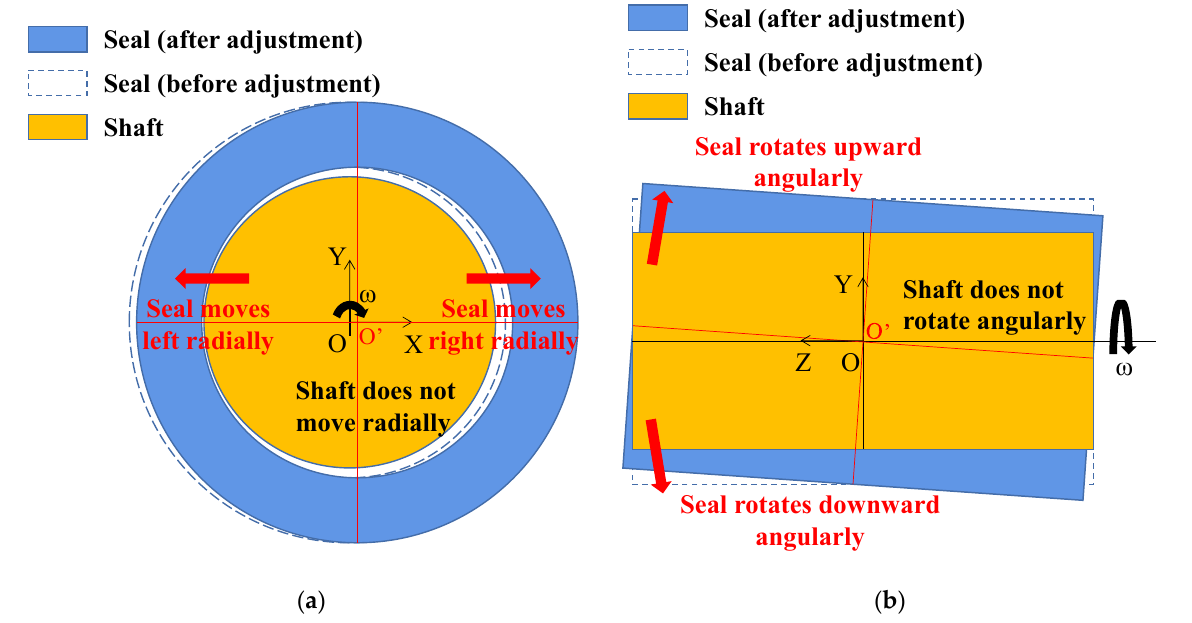
Figure 12. Installation error environment adjustment principle (radial and angular eccentricity). ( a ) Radial eccentric adjustment principle; ( b ) angular eccentric adjustment principle.